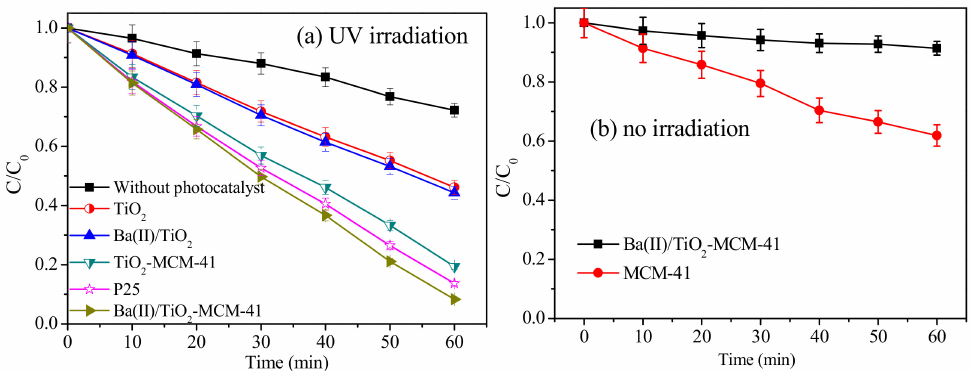
Figure 7. Photodegradation efficiencies of p-nitrobenzoic acid by different photocatalysts under ( a ) UV irradiation and ( b ) no irradiation (reaction conditions: C 0 = 4 × 10 − 4 mol/L, dosage of material = 0.5 g/L, initial pH = 4.0 ± 0.1).